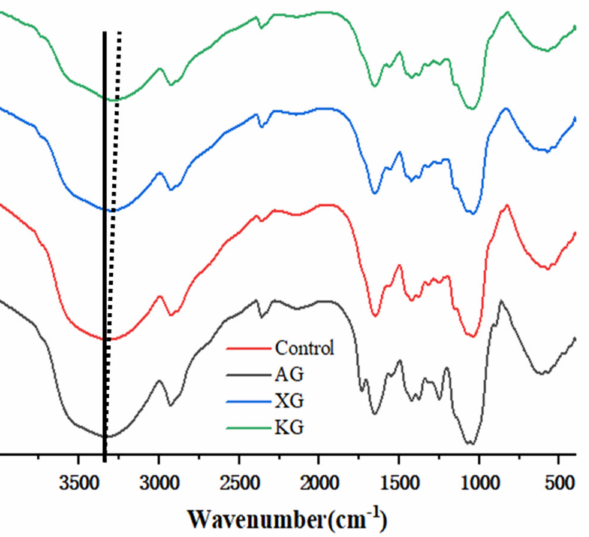
Figure 6. FTIR spectra for ink samples with different gum at concentration of